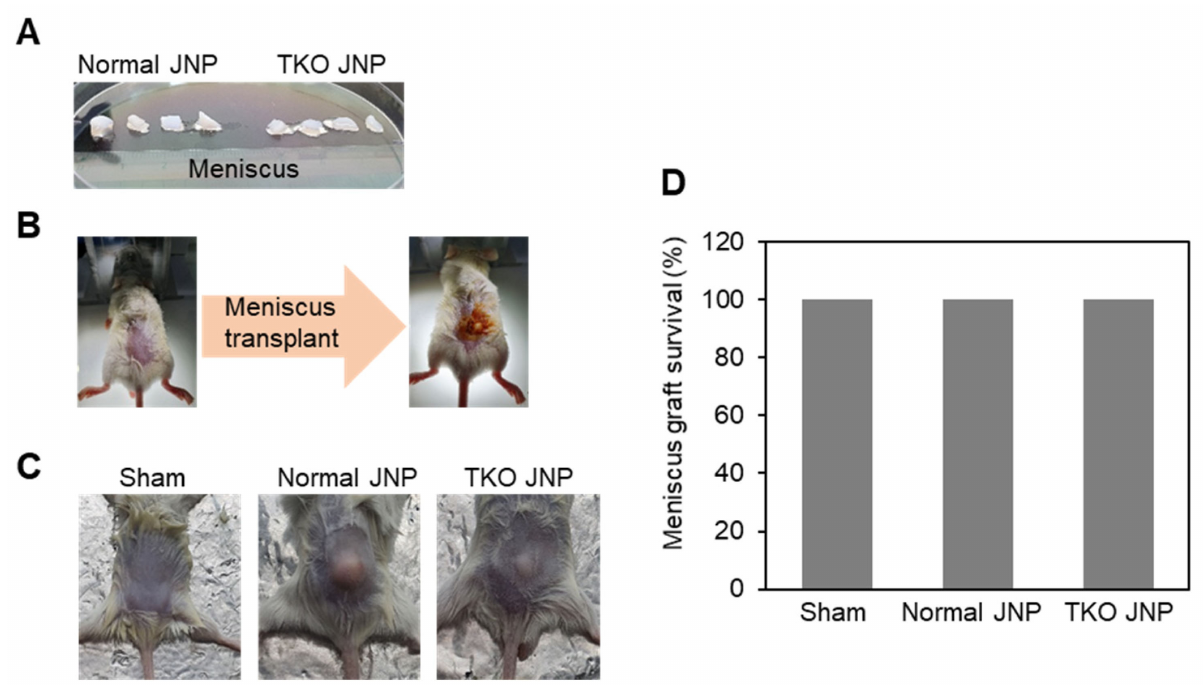
Figure 1. Procedures for meniscus transplantation of normal/TKO JNP and graft survival rate. ( A ) The meniscus from the normal and TKO JNP groups was removed and divided into sections measuring about 50 mm 3 . ( B ) Mice were given isoflurane anesthesia while the meniscus was implanted in the dorsal back dermis. ( C ) After three weeks of breeding, the mice were euthanized for additional histological analysis. ( D ) Meniscus graft survival rate was illustrated.